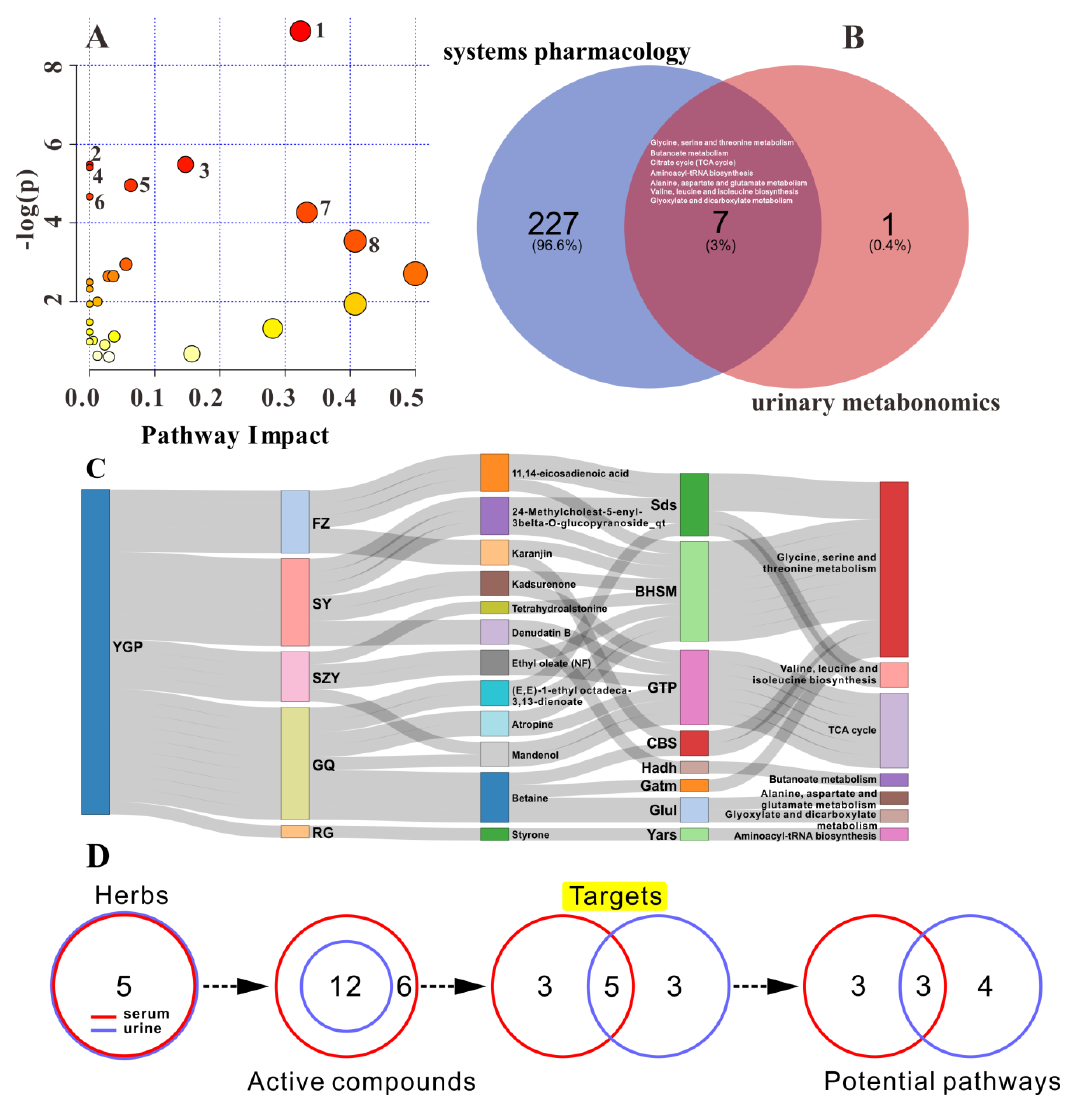
Figure 6. ( A ) The metabolic pathways corresponding to differential metabolites in urine sample; and ( B ) overlapping pathways between systems pharmacology and urinary metabonomics analysis. The numbers in A correspond to the serial numbers of the metabolic pathway in Table S2, while the white pathway in B represents seven overlapping metabolic pathways. ( C ) The network of YGP–herbs–active compounds–target proteins–pathways. ( D ) Comparison of metabonomics and systems pharmacology studies between urine and serum samples.